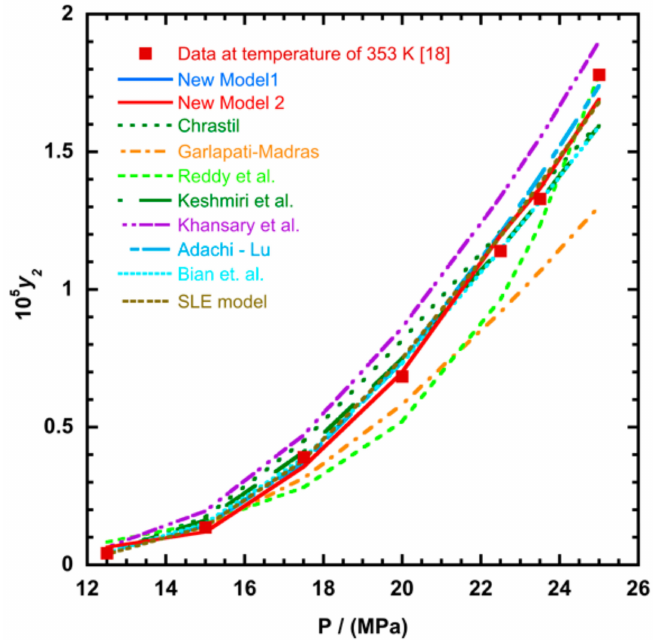
Figure 6. Plot of mole fraction solubility of Red 15 (1-amino-4-hydroxyanthraquinone) against pressure (P/MPa), the solid lines present the new model 1 (Equation (18)) and the new model 2 (Equation (21)), respectively.